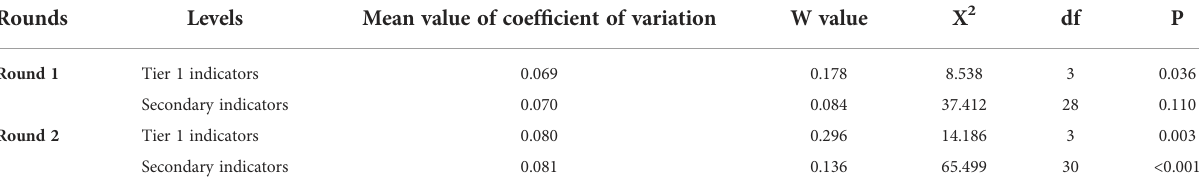
TABLE 4 Level of coordination of expert